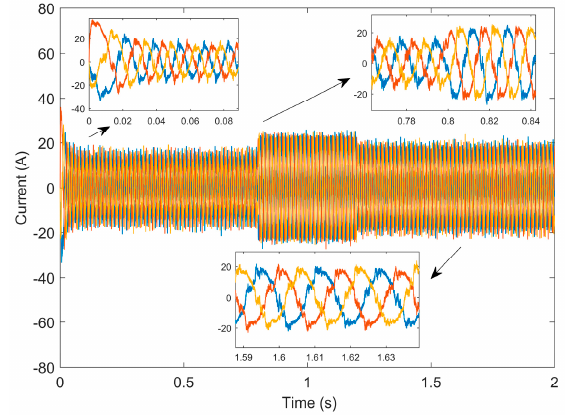
Figure 8. Current variation waveform of the PI.